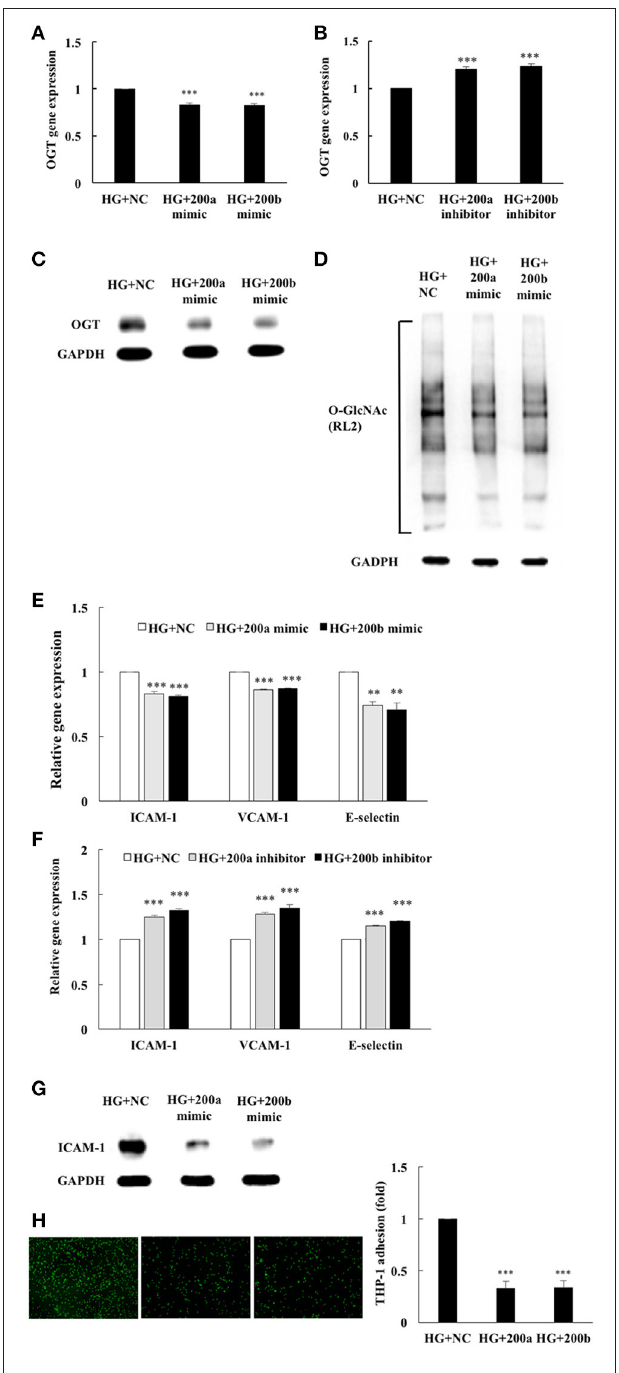
FIGURE 3 | miR-200a/200b mimics inhibited HG-induced endothelial OGT expression, protein O -GlcNAcylation, and inflammatory phenotypes. (A) Transfection of miR-200a/200b mimics inhibited HG-induced endothelial OGT mRNA expression to 83 and 82% of the control level, respectively N = 4. *** p < 0.001 compared with the HG-treated HAECs transfected with a negative control (HG + NC). (B) Transfection of miR-200a/200b inhibitors enhanced HG-induced endothelial OGT mRNA expression to 1.20- and 1.23-fold of the control level, respectively N = 4. *** p < 0.001 compared with HG + NC. (C) The stimulatory effect of HG on OGT protein expression was